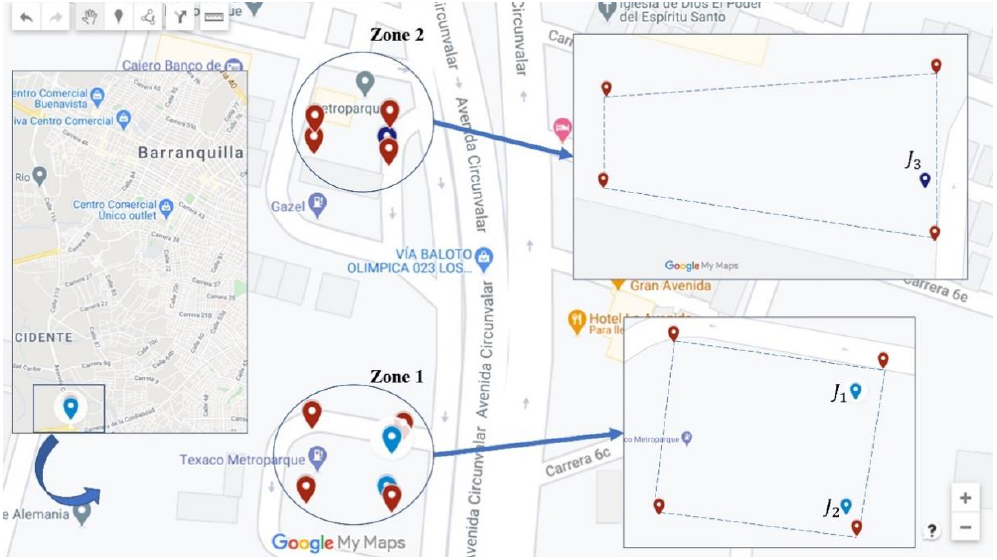
Figure 10. Location of transshipment urban logistics spaces.